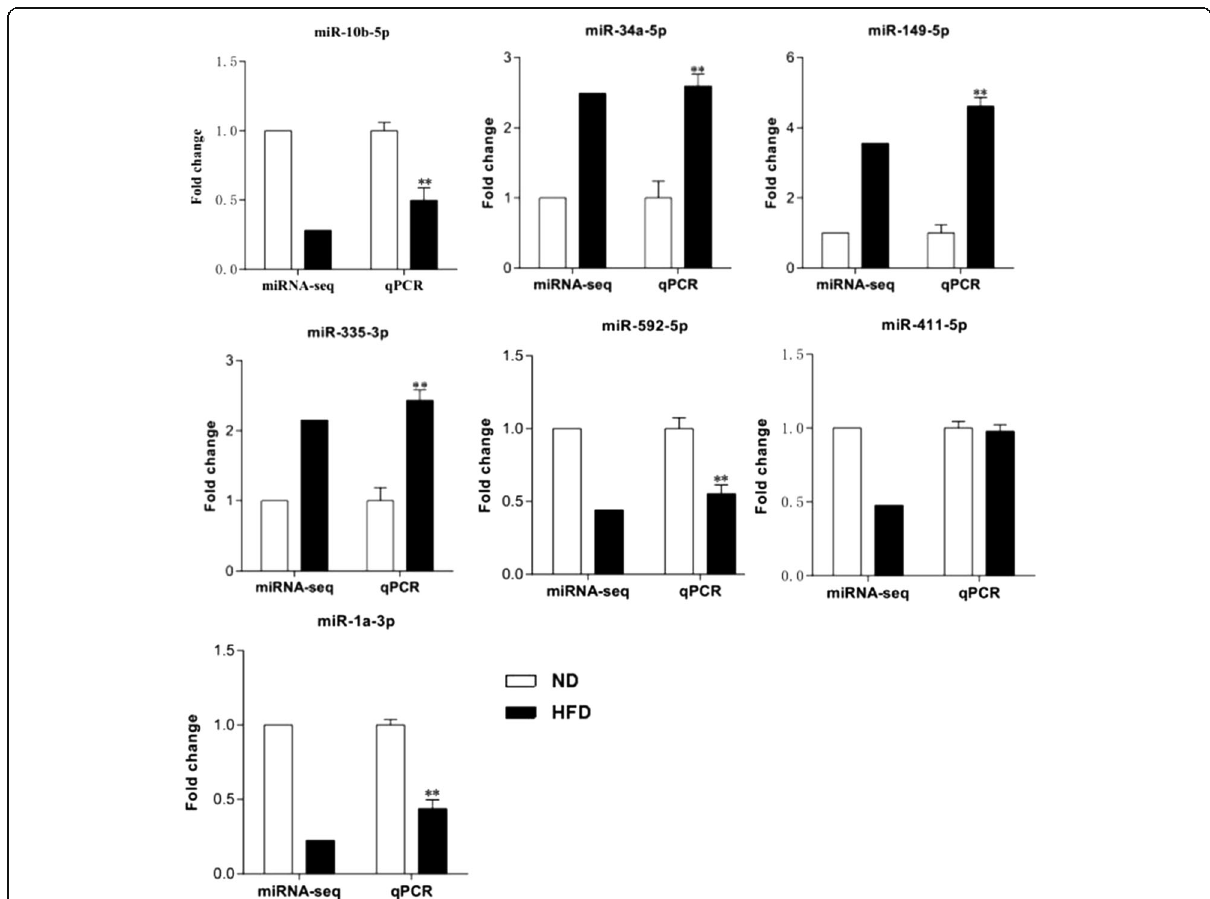
Fig. 7 q-PCR validation of some differentially expressed miRNAs identified using high-throughput sequencing in mouse liver tissues. ND, normal diet mice; HFD, high-fat diet mice. * P < 0.05, ** P < 0.01, compared with the value of the ND group